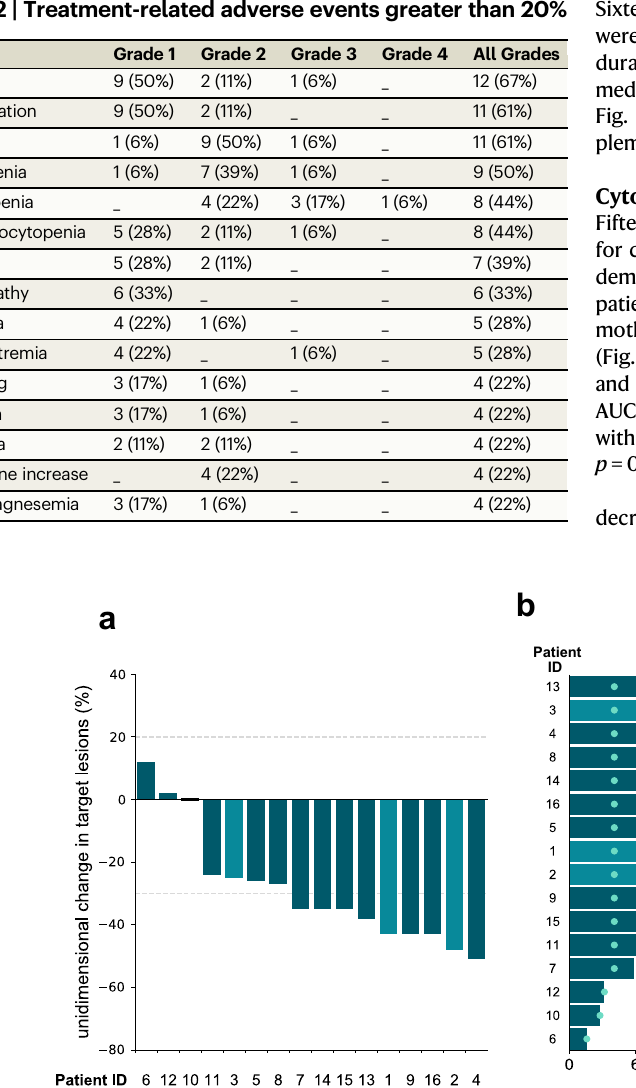
Table 2 | Treatment-related adverse events greater than 20%